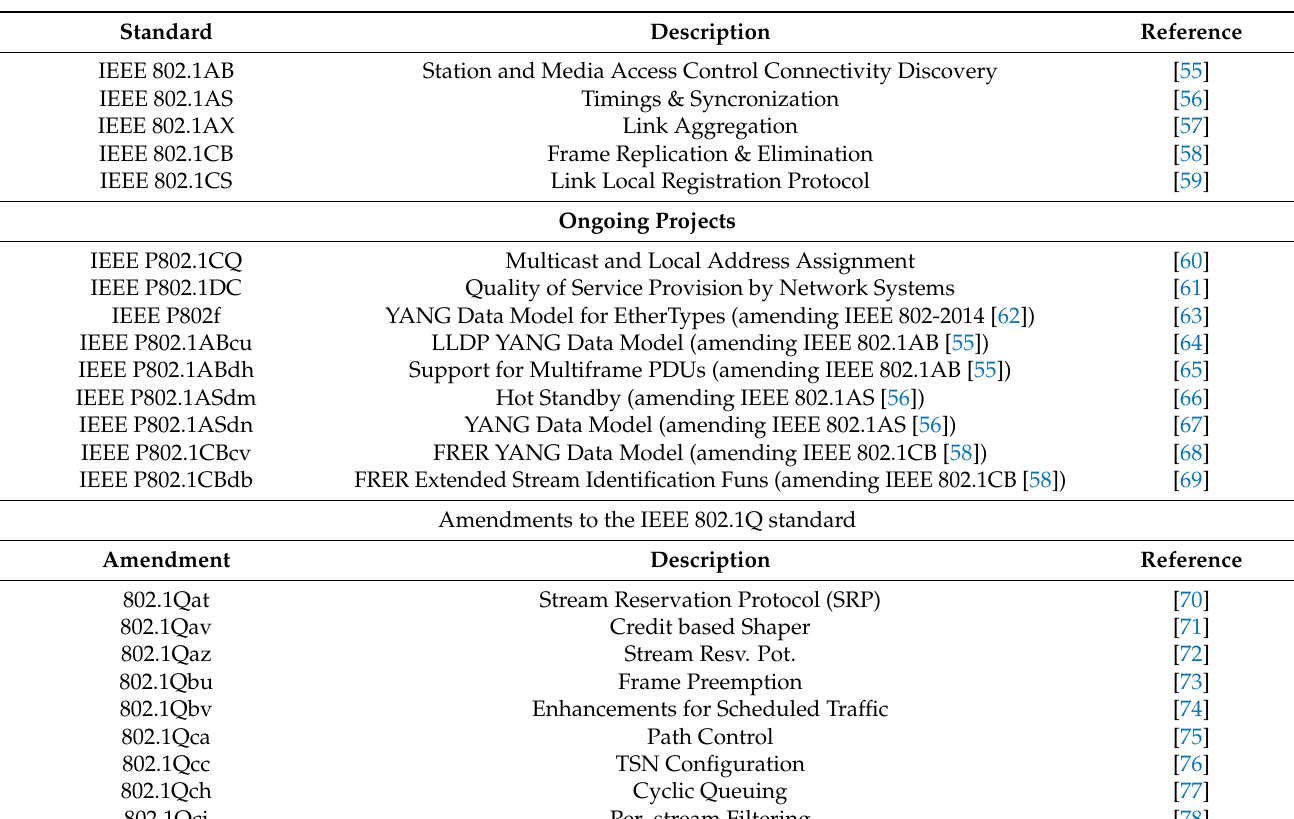
Table 2. The TSN standardization